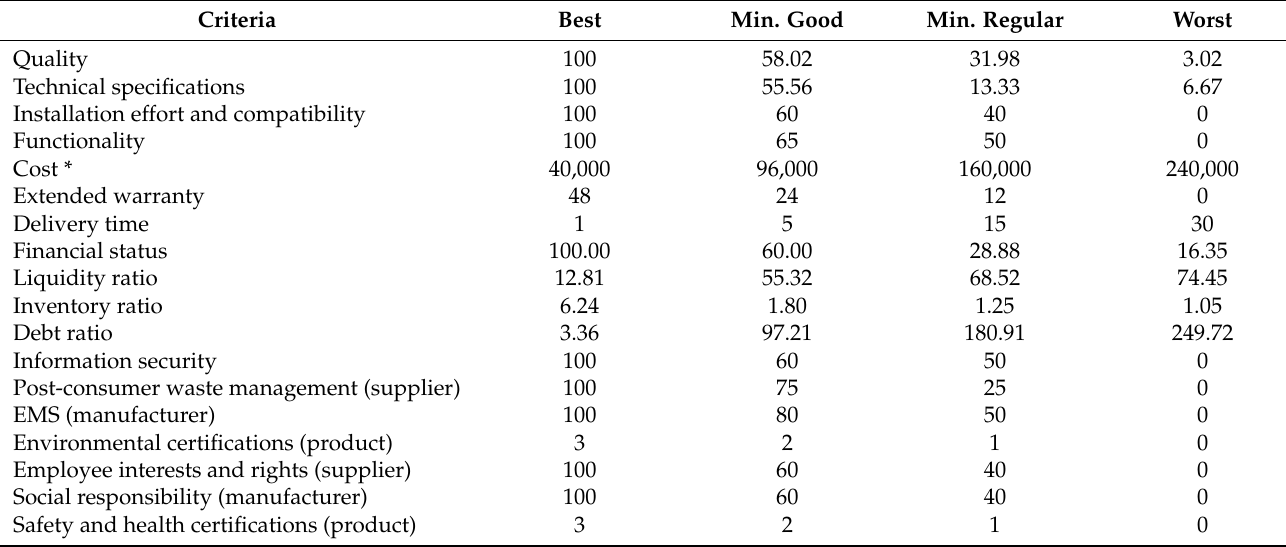
Table A3. Reference profiles of supplier